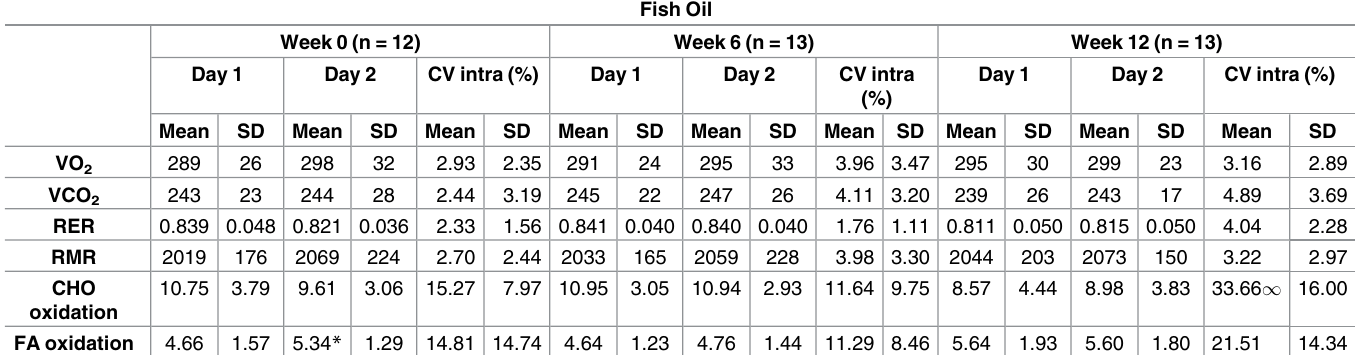
Metabolic measurements Day-to-day variability. There was a high degree of repeatability between consecutive day metabolic measurements at weeks 0, 6 and 12, as there were no differences between days (Tables 2 and 3). The one exception was FAOx in the FO group at week 0 which was higher (p = 0.02) on day 2 (Table 3). The mean intra-individual coefficient of variation (CVintra) ranged from 1.76–4.89% for VO , VCO , RER, and RMR after consecutive morning measurements on three different occa- 2 2 sions. This variation was similar in the OO and FO groups (Tables 2 and 3). CVintra for FA oxidation ranged from 12.80–15.65% in the OO group and 11.29–21.51% in the FO group. The CVintra for CHO oxidation was similar and ranged from 11.55–17.85% in the OO group and 11.64–15.27% in the FO group, with the exception of week 12 (33.66%) which was greater (p < 0.001) than weeks 0 and 6 (Table 3). Table 3. Resting metabolic rate, substrate oxidation, and within individual coefficient of variancebetween consecutive day measurements with fish oil supplementation. Fish